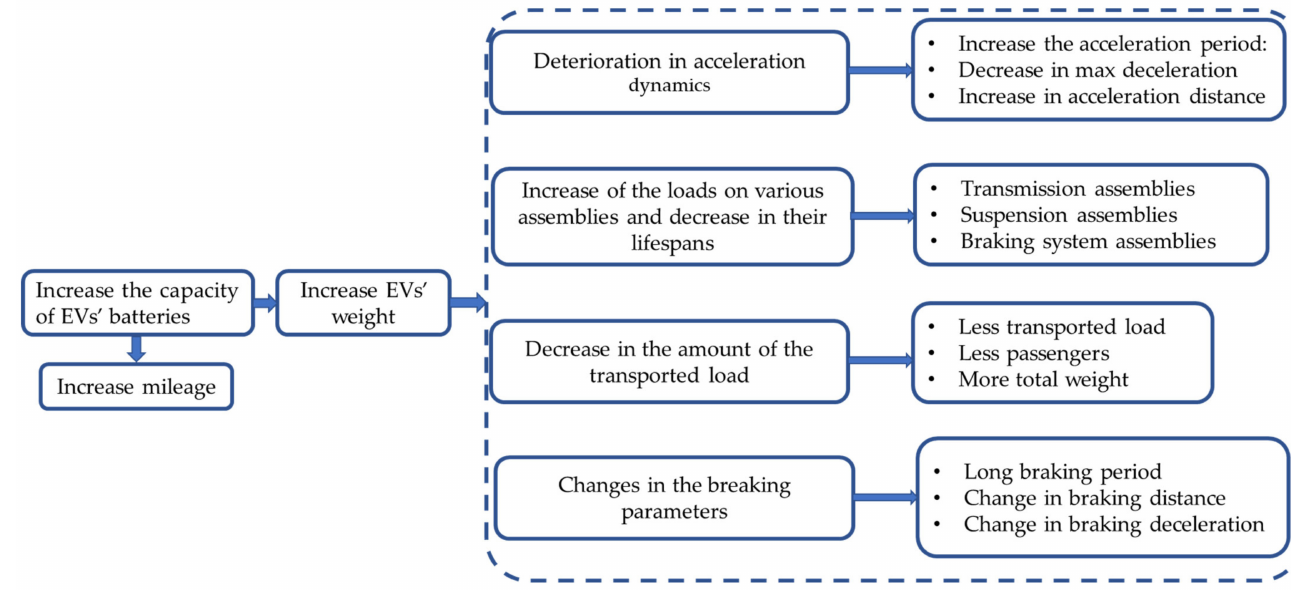
Figure 3. Impact of the batteries on the EV performance [12]. Reproduced from [12], ENGINEERING FOR RURAL DEVELOPMENT: